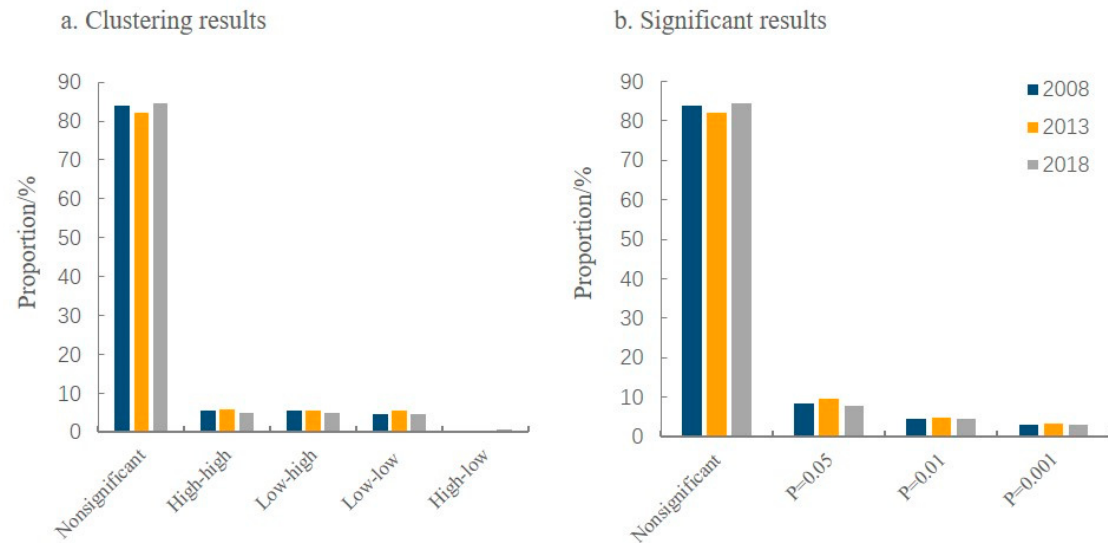
Figure 3. Changes in the local spatial autocorrelation of land-use conflict in Lin’an District, 2008–2018. ( a ) Clustering results. ( b ) Significant results.